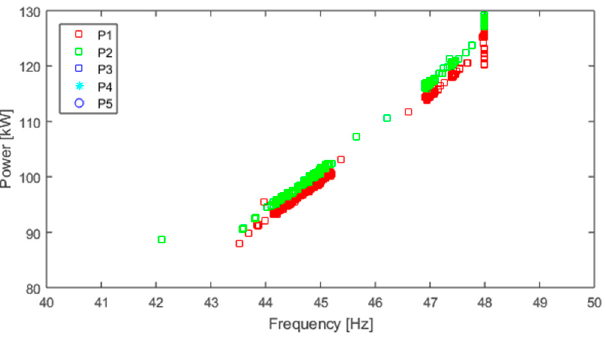
Figure 8. The characteristic F = f ( P i ) for the hydraulic regime with two pumps in operation.